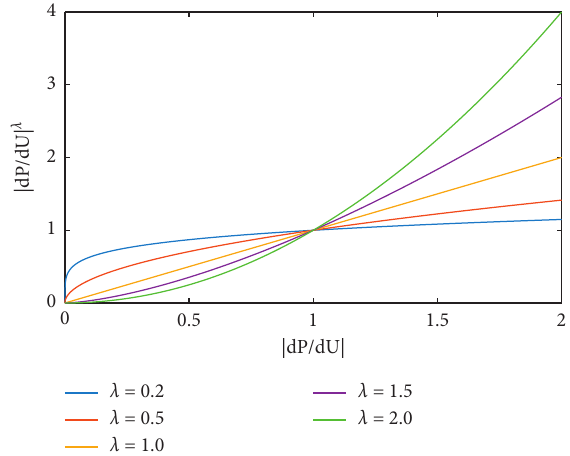
Figure 8: The effect of λ ( k ) on | d P /d U | figure is the variable step algorithm of Versoria, and the pink curve is the fuzzy control algorithm. At the initial moment, the light intensity changes from 0 W/m 2 to 800 W/m 2 ; at 0.05 s, the light intensity changes from 800 W/m 2 to 500 W/ m 2 ; and at 0.1 s, the light intensity changes from 500 W/m 2 to 1000 W/m 2 .